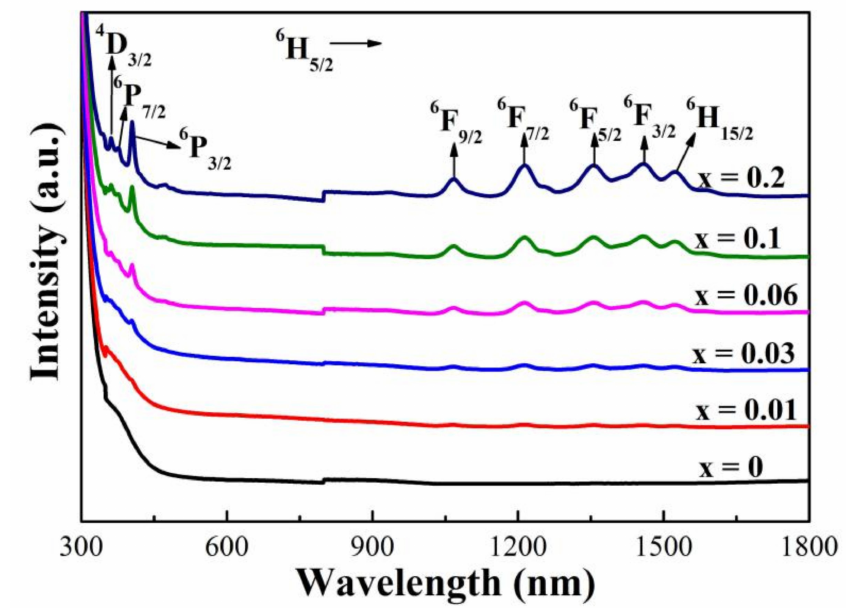
Figure 5. The absorption spectra of Al 2 O 3 -(3-x)SrO: xSm 3+ (x = 0, 0.01, 0.03, 0.06, 0.1, 0.2)